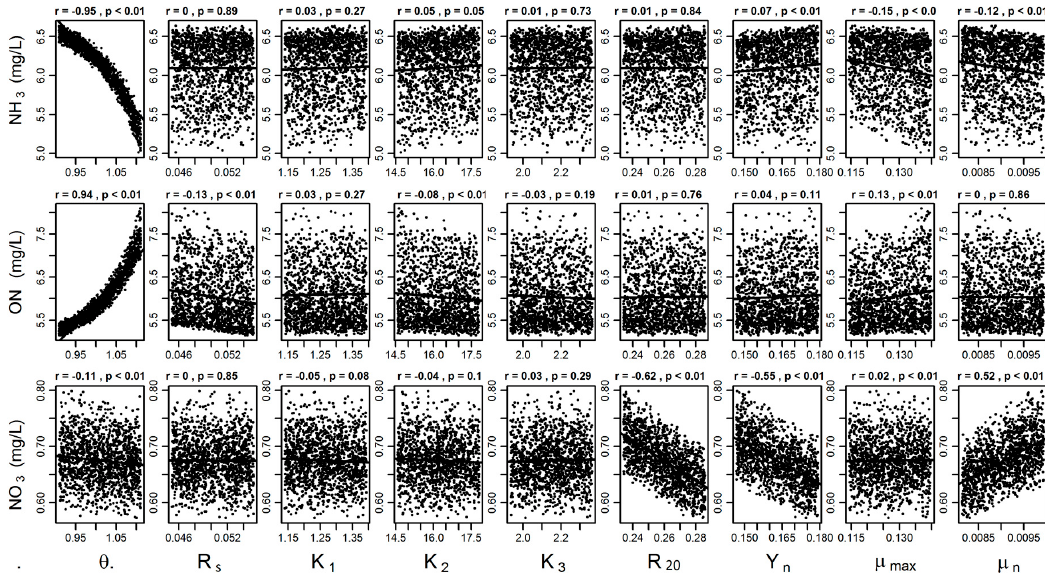
Figure 5. Global sensitivity analysis results of ammonia nitrogen (NH3-N), organic nitrogen (ON-N), and nitrate (NO 3 -N) for the one-year calibration and validation period (2014–2015), as a function of uniform distribution of the parameter values.